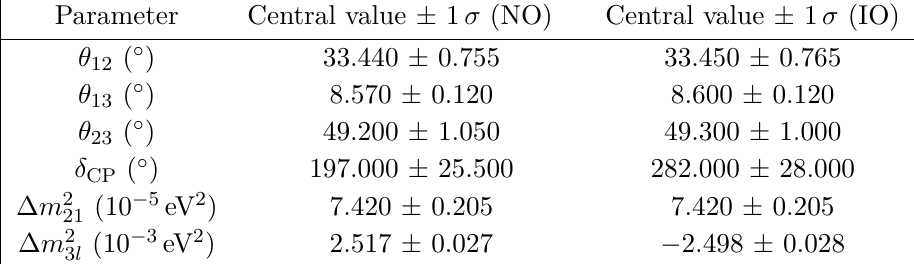
Table 3 . The best-fit values and 1 σ confidence level (CL) uncertainties in the standard three- neutrino mixing [3, 75]. The values are shown for both normal ordering (NO) and inverted order- ing (IO), where ∆ m 2 corresponds to ∆ m 2 (NO) and ∆ m 2 (IO), 31 32 3 ‘